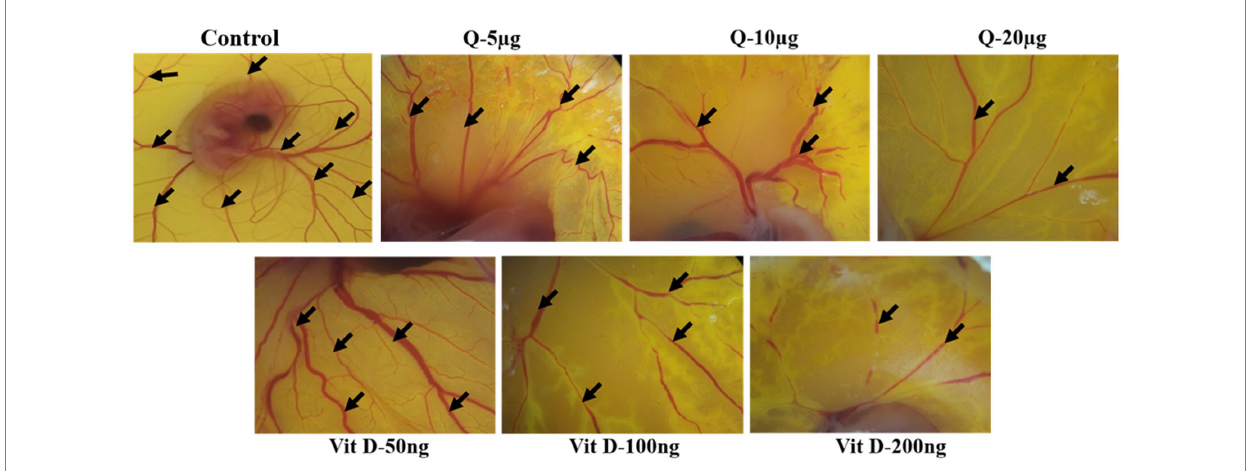
FIGURE 6 Quercetin inhibits ex-vivo -angiogenesis. Anti-angiogenic effect of quercetin and vitamin D3 on chorioallantoic membrane of fertile chicken eggs. Microscopic images were representing the suppression of number of blood vessels in quercetin and vitamin D3 treated eggs compare to control eggs in dose dependent manner ( n = 5).